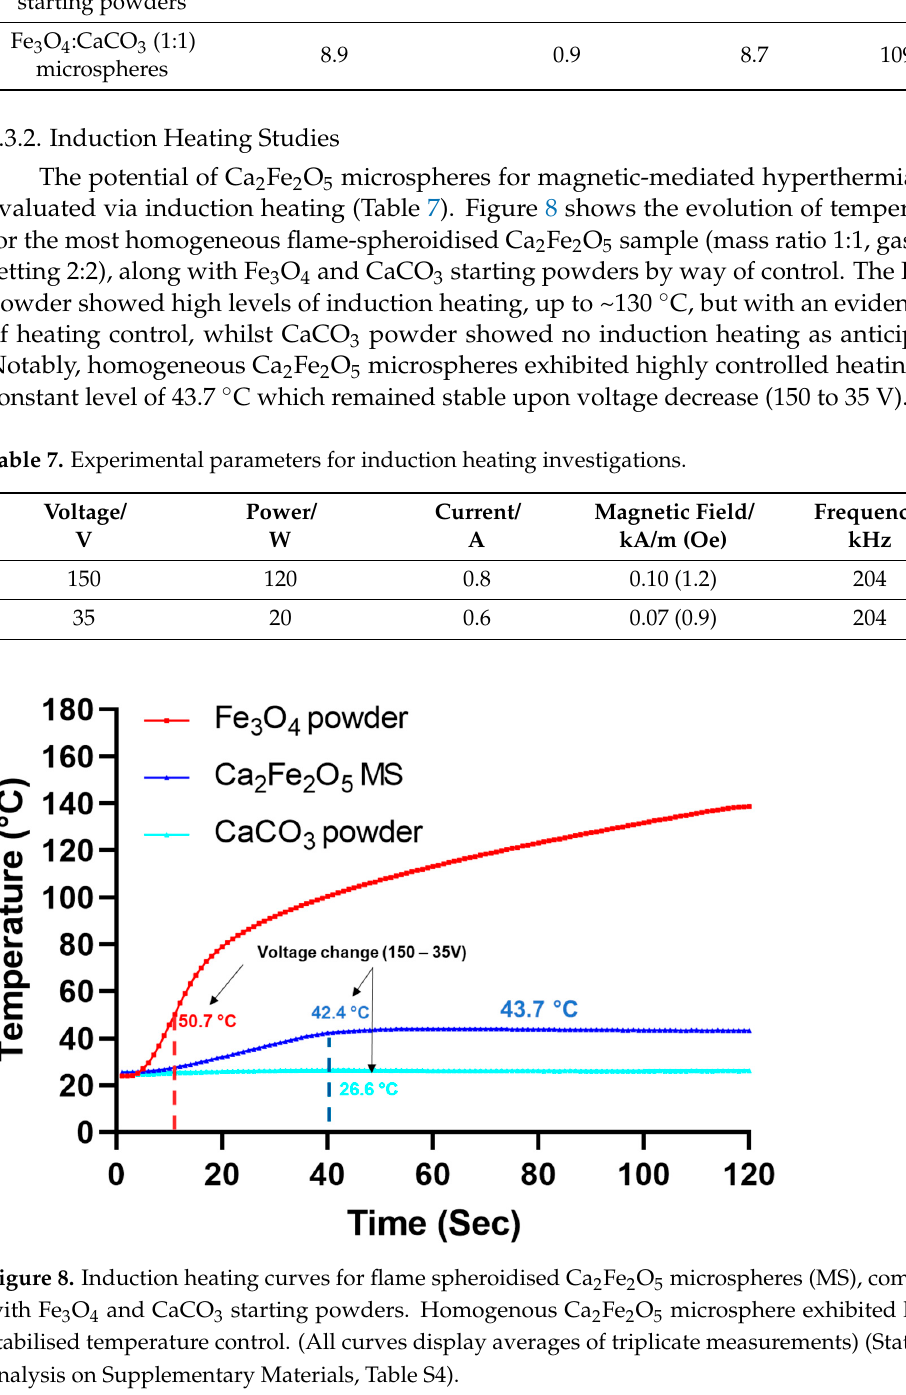
Table 6. Magnetic saturation, remanent magnetisation and coercive fi eld values of Fe 3 O 4 dense mi-